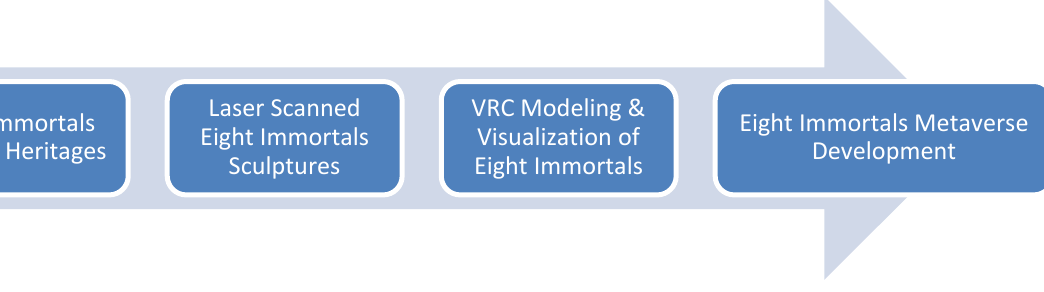
Figure 11. The process of turning Eight Immortals cultural heritage into an Eight Immortals metaverse.